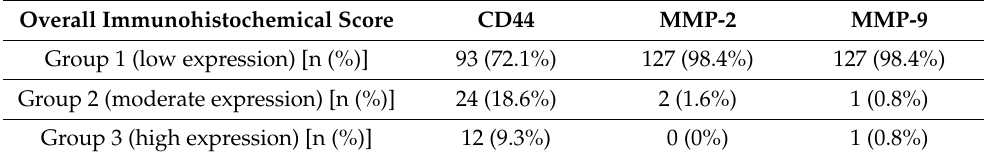
Table 2. CD44, MMP-2 and MMP-9 immunoreactivity of clear cell renal cell carcinoma